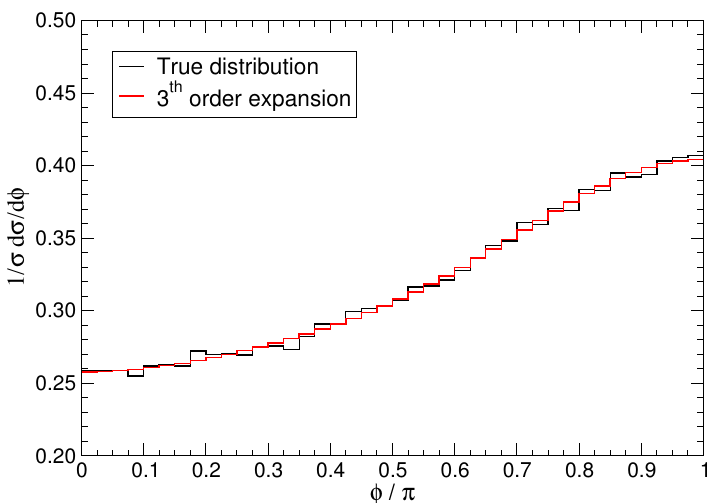
Figure 3 . Normalised d(cid:27)=d(cid:30) distribution (in bins of (cid:25)= 40) obtained from Monte Carlo at 8 TeV (black), compared to the third order expansion with the coe(cid:14)cients in table 3. tion is not only determined by the (cid:12)rst coe(cid:14)cient b , but by a combination of the even 0 coe(cid:14)cients, 1 = (cid:25) b + (cid:25)= 4 b + 9 (cid:25)= 64 b + (cid:1) (cid:1) (cid:1) . Therefore, the simpler expansion 0 2 4